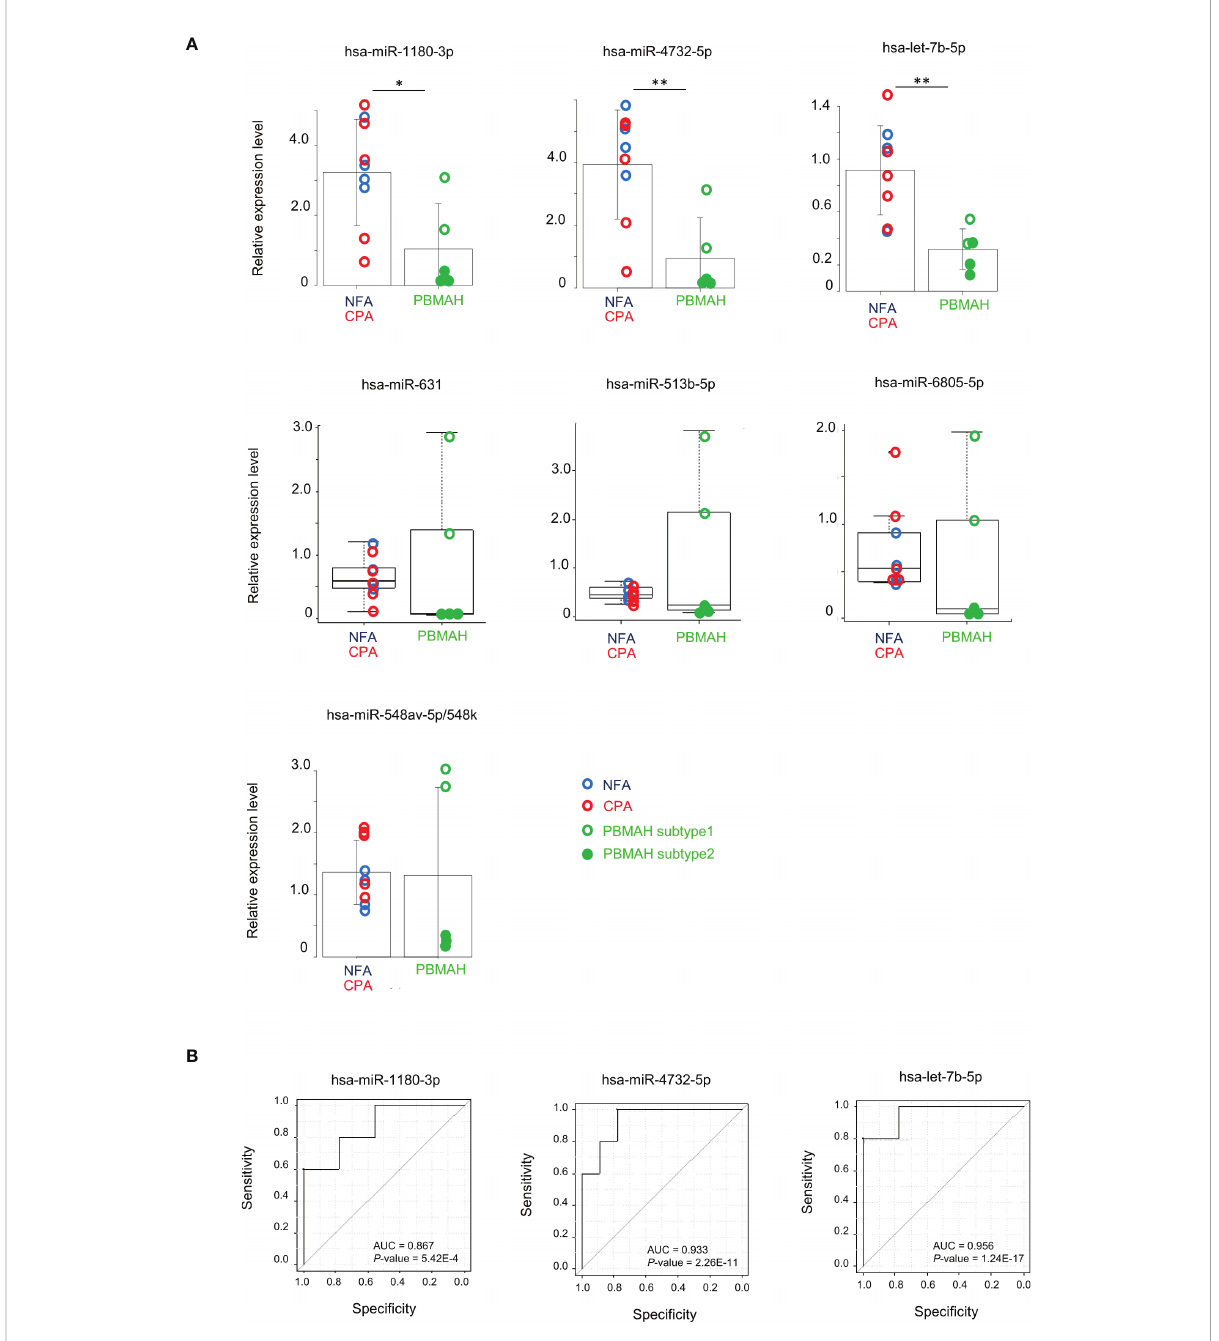
FIGURE 2 Evaluation of miRNAs expression between adenoma (NFA and CPA) and PBMAH. (A) RT-qPCR analysis of hsa-miR-1180-3p, hsa-miR4732-5p, hsa-let-7b-5p, hsa-miR-631, hsa-miR513b-5p, hsa-miR6805-5p, and hsa-miR-548av-5p/548k. Data were normalized to hsa-miR16-5p and are shown with regard to the classi fi cation of adenomas including NFA (blue circle, n = 4), CPA (red circle, n = 5), and PBMAH (green circle, n = 5). Patients with PBMAH were divided into two subtypes based on hierarchical clusters. Subtype 1 (green open circles) includes sample numbers 11 and 14, and subtype 2 (green closed circles) includes sample numbers 10, 12, and 13. Student ’ s t -test or Mann-Whitney U test was used for the classi fi cation of adenoma versus PBMAH and bar plots with mean ± SD or box plots with the upper and lower quartiles and the median were shown for each analysis, respectively. * P < 0.05, ** P < 0.01. (B) ROC curves for the prediction of PBMAH by hsa-miR-1180-3p, hsa-miR4732-5p, and hsa-let-7b-5p. Area under the curve (AUC) and P- values are also